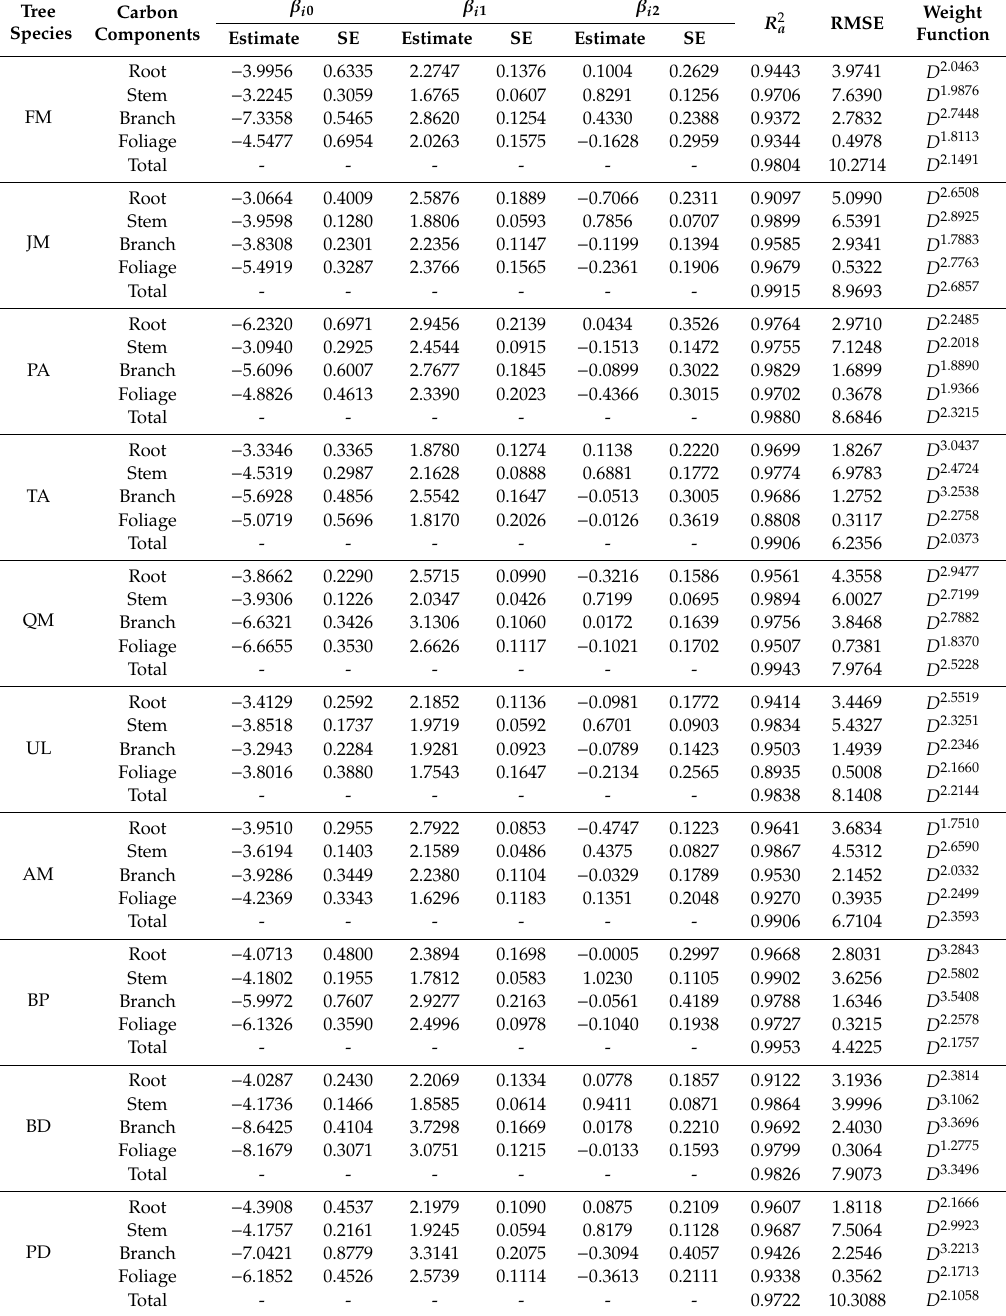
Table 4. Model coe ffi cient estimates, standard errors, goodness-of-fit statistics, and weight functions for the additive system of biomass equations based on two predictors ( D and H , namely